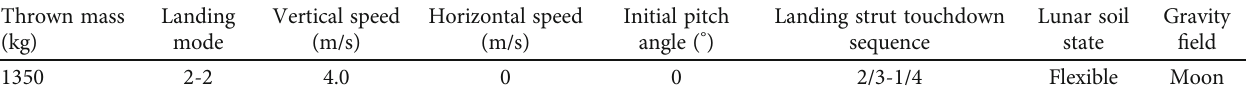
Table 12: Simulation analysis conditions of soft